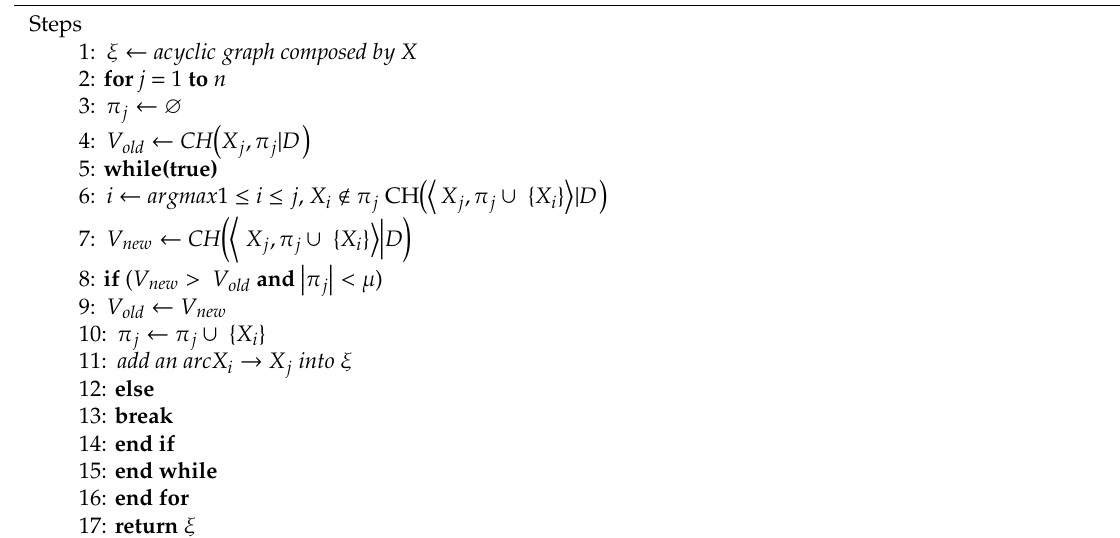
Table 1. K2 algorithm